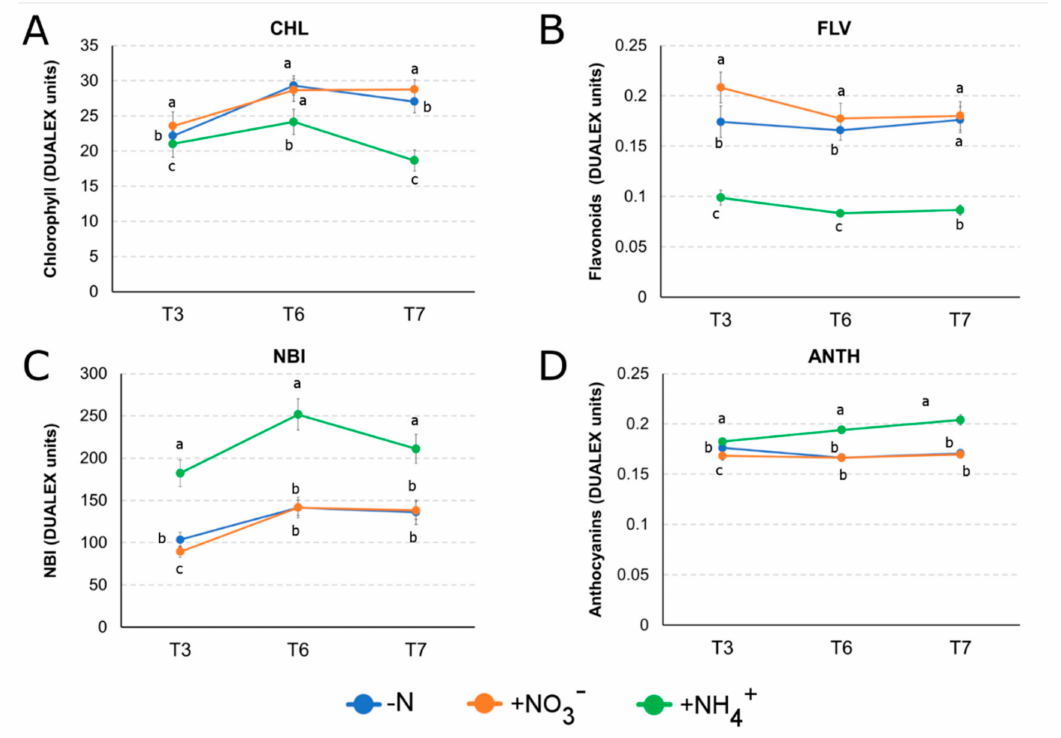
Figure 7. Values of ( A ) leaf chlorophyll content, ( B ) leaf flavonoids content, ( C ) leaf anthocyanins content and ( D ) Nitrogen Balance Index. Maize seedlings were grown 24 h in a N-deprived nutrient solution and then transferred to a 1mM N-supplied media (NO 3 − or NH 4 + ) or to a N-deprived solution (-N) for additionally 3 days (T3), 6 days (T6) and 7 days (T7). Epidermis absorbance was obtained with the optical sensor DUALEX SCIENTIFIC + TM (Force-A) at the same hour of every time point. Values represents means of three replicates ± SE. Similar letters at corresponding dot within treatments are not significantly di ff erent ( p < 0.05) by an ANOVA